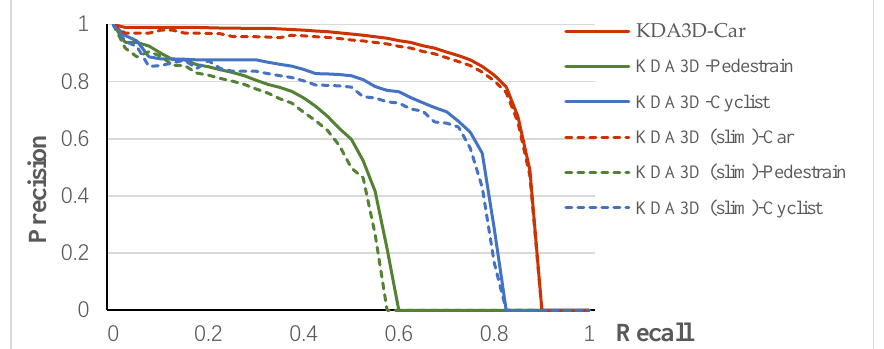
Figure 8. Precision-recall curves of our methods for 3D object detection on the most important “Moderate” instances of the KITTI val set. The solid lines refer to KDA3D and the dotted lines refer to KDA3D (slim).